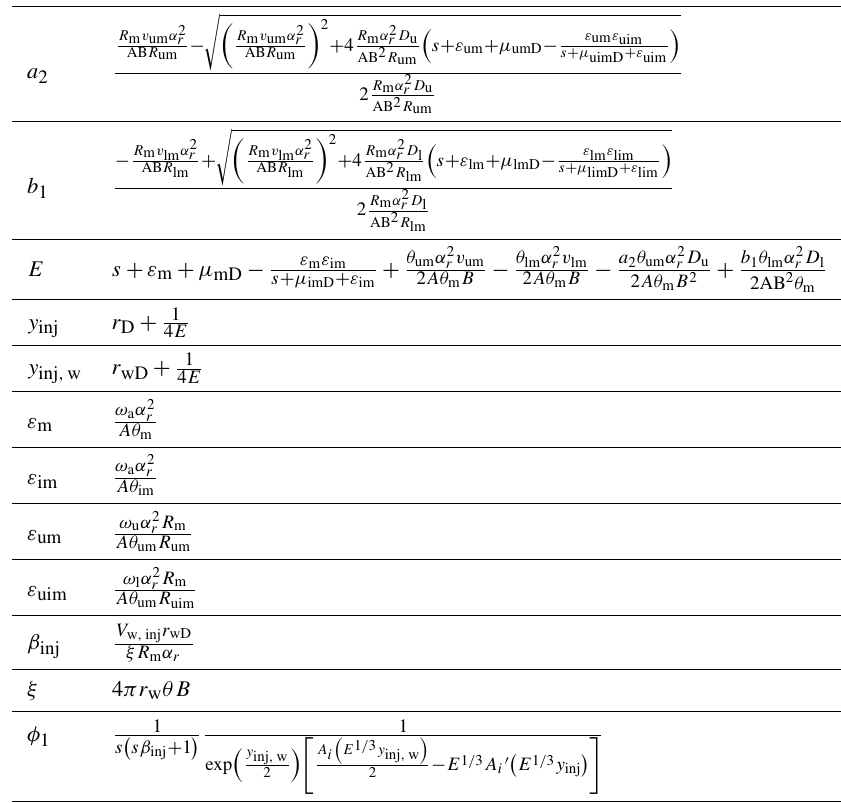
Table 1. Expressions of the coefficients in the solutions expressed in Eq.